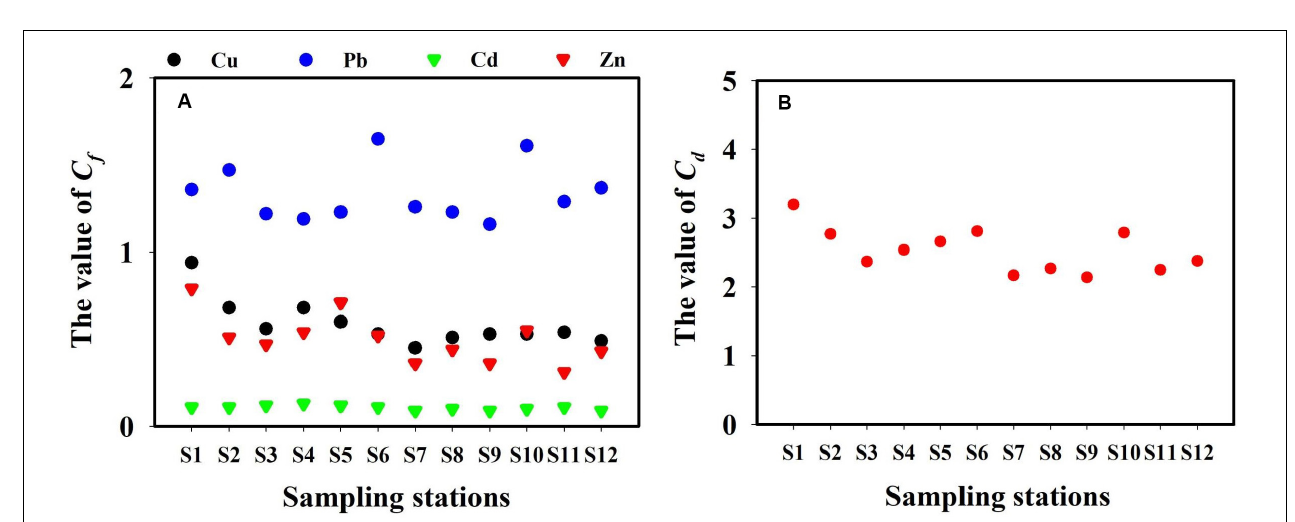
FIGURE 7 | C f and C d for total dissolved TMs (annual mean concentrations) in the surface seawater of Sishili Bay. (A) Value of C f and (B) the value of C d .